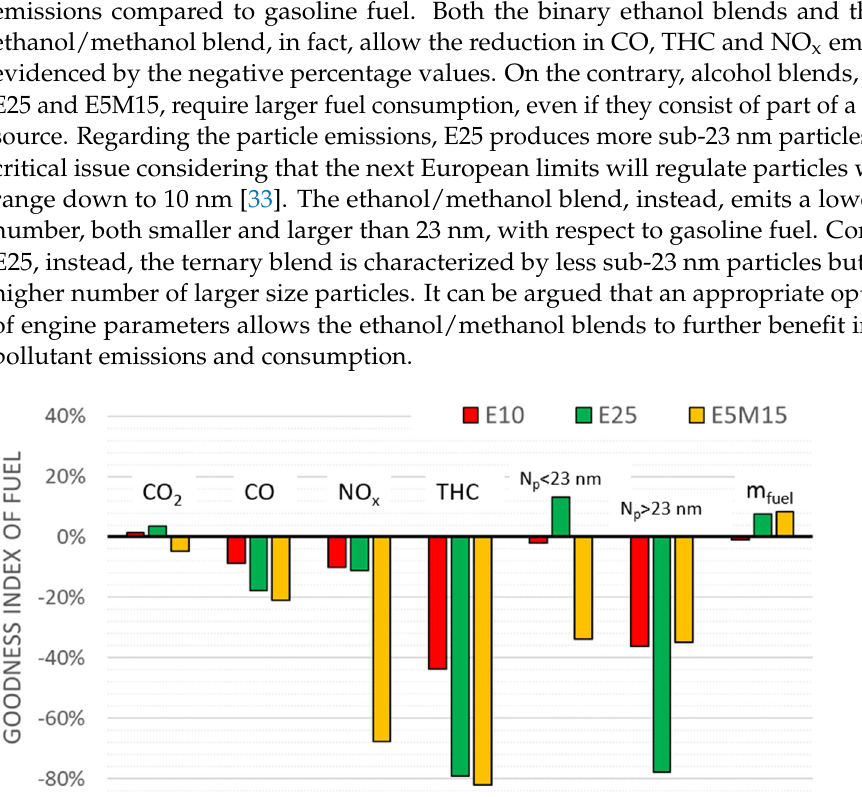
Figure 10. Total particle number emitted from gasoline, E10, E25 and E5M15.